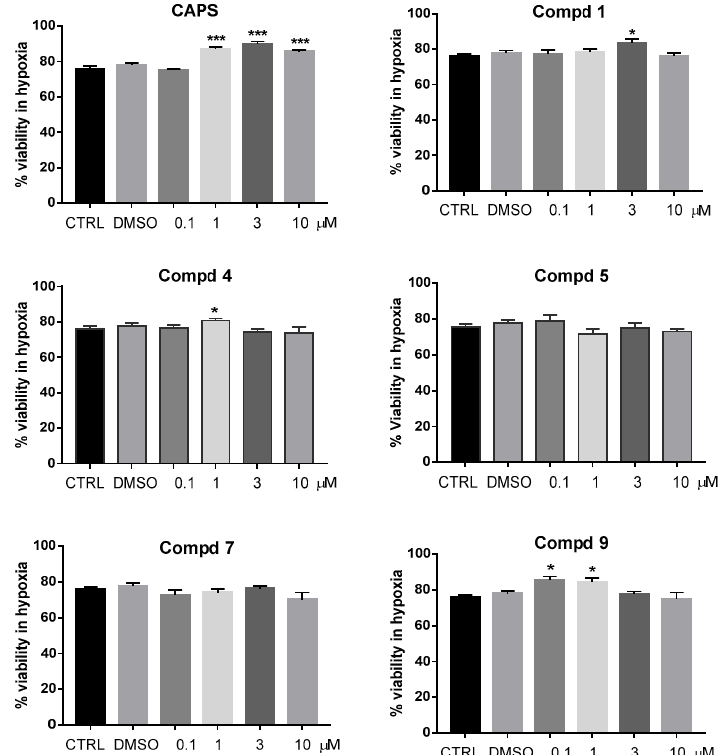
Figure 3. Cell viability after 48 h hypoxia in the presence or in the absence of capsaicin and compounds 1, 4 – 5, 7 and 9 . Cell viability is expressed as a percentage calculated by division of the absorbance values obtained after 48 h hypoxia (2% O 2 , 5% CO 2 and 93% N 2 ) by those obtained in normoxia. Each point represents the mean ± SEM of five independent experiments. * p < 0.05, *** p < 0.001 vs. CTRL, (ANOVA and Bonferroni post hoc-test).